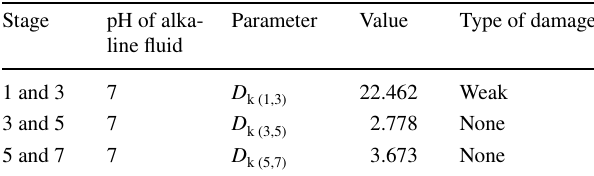
Table 4 Determination of the degree of formation damage ( D core no.